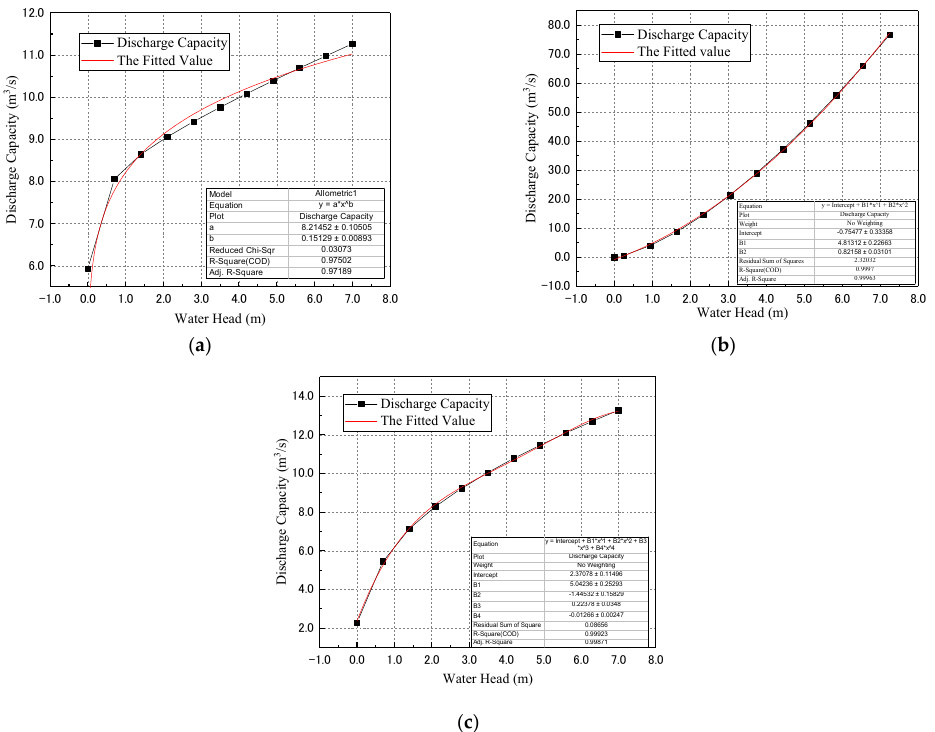
Figure 4. Fitted value of results calculated through simplified algorithm for discharge capacity: ( a ) free flow; ( b ) half-pressure flow; and ( c ) pressure flow.